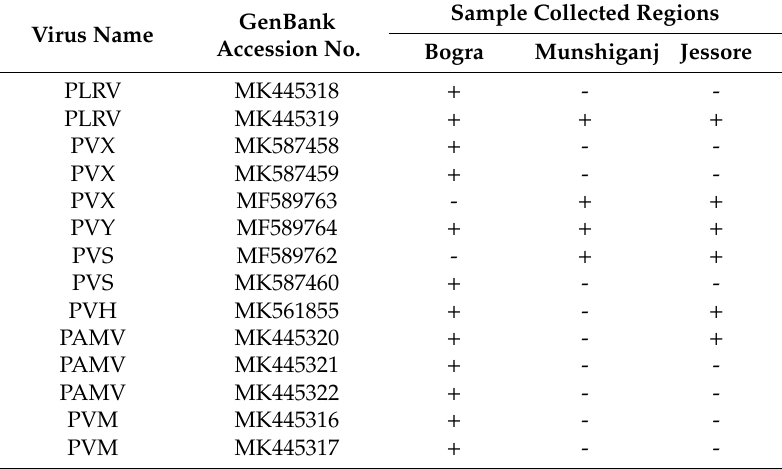
Table 2. Virus sequences obtained from three major potato growing regions (Munshiganj, Jessore and Bogra districts) of Bangladesh in this